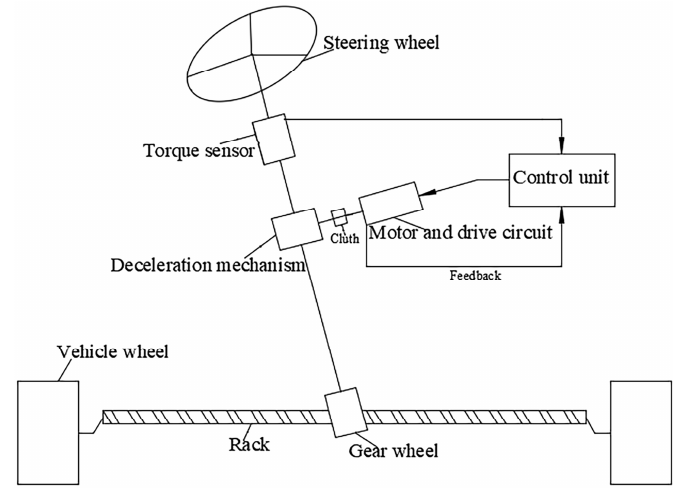
Figure 1. EPS mechanism model.